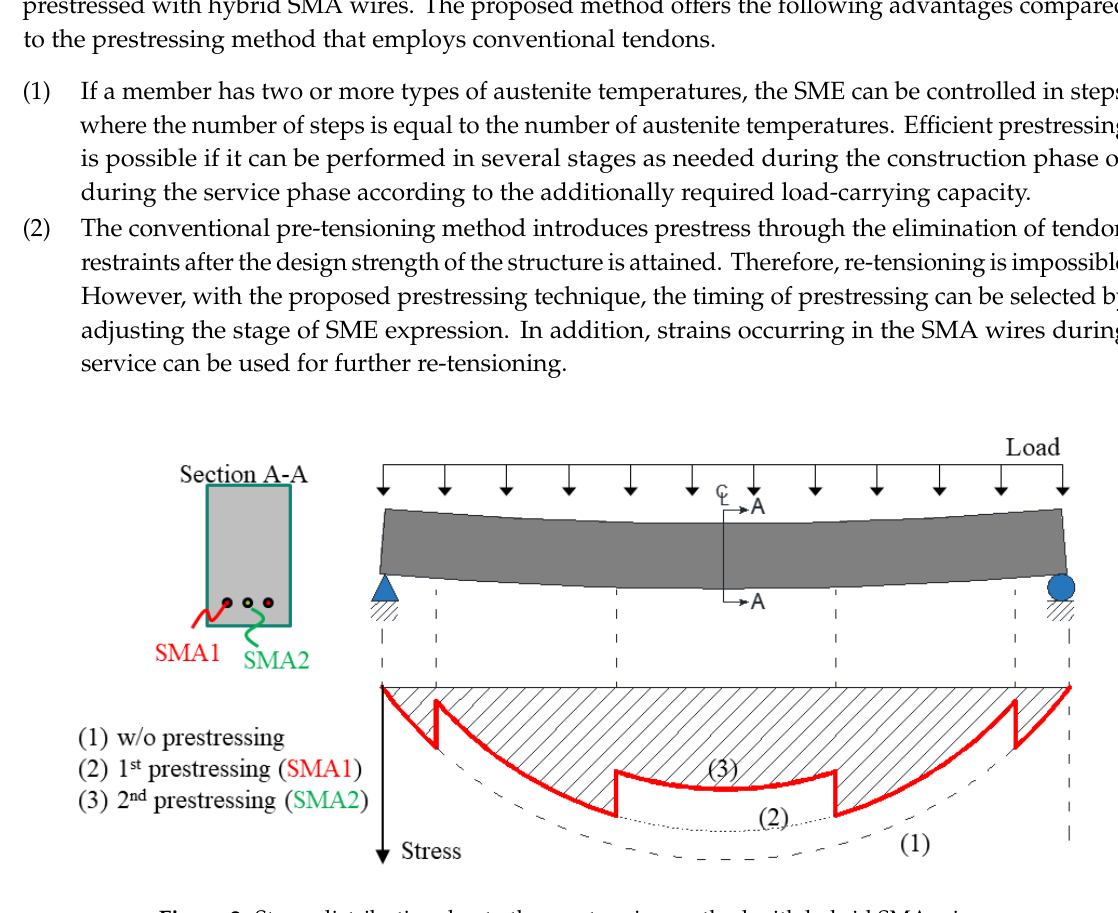
Figure 2. Stress distribution due to the prestressing method with hybrid SMA wires.